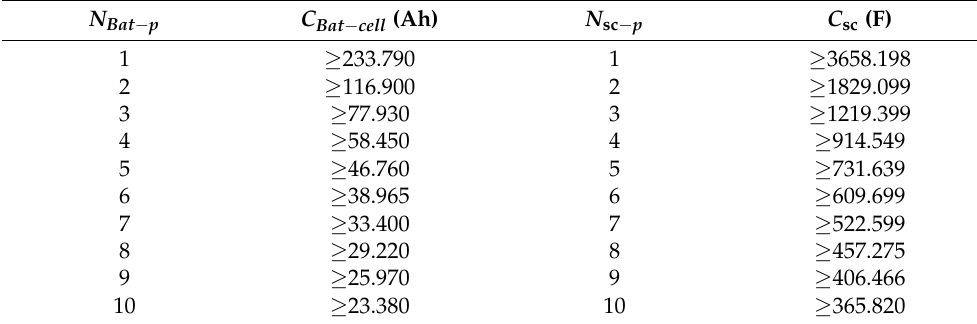
Table 3. The capacity ranges of cell under different parallels.